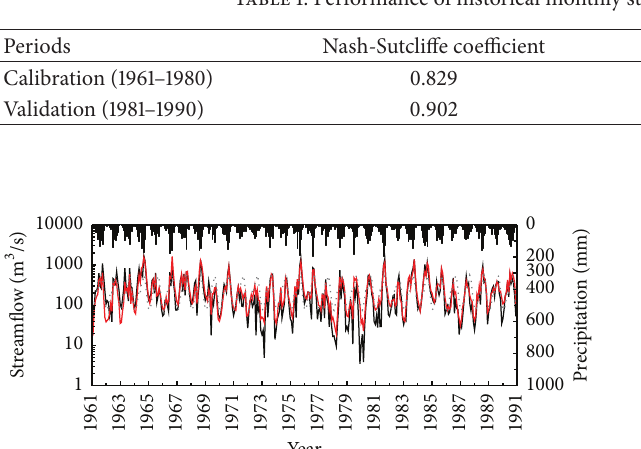
Table 1: Performance of historical monthly streamflow simulations at Huaxian station.